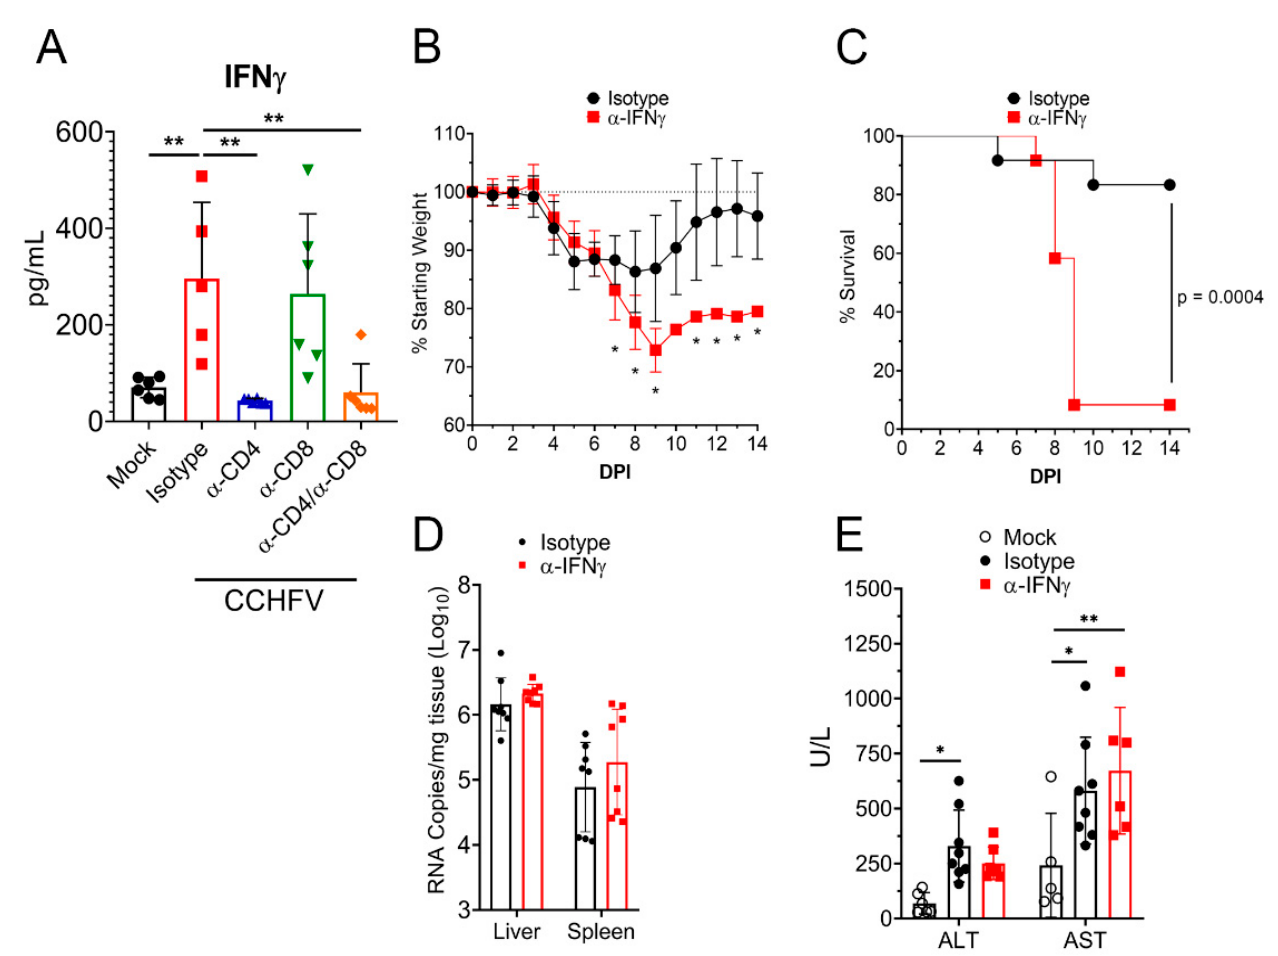
Figure 6. IFN γ is required for survival following CCHFV infection. ( A ) IFNAR − / − mice were infected with CCHFV or mock-infected. Mice were treated as indicated with isotype-control antibody, antibody to deplete CD4 or CD8 T-cells or both. On day 8 PI, plasma IFN γ levels in mice were measured by Bio-plex assay. Statistical comparison performed with a one-way ANOVA and Tukey’s multiple comparison test. ( B – D ) IFNAR − / − mice were infected with CCHFV and treated with isotype-control antibody or α -IFN γ antibody to neutralize IFN γ . Mice were weighed daily ( B ) and euthanized according to criteria outlined in methods ( C ). ( B ) N = 12 per group. Statistical comparison between isotype-control treated and α -IFN γ -treated mice performed with a two-way ANOVA with Sidak’s multiple comparison test. * p < 0.05. ( C ) N = 12 per group. Statistical test between survival curves performed using Log-rank test. ( D ) At day 8 PI, viral RNA loads in the liver or spleen were quantified by qRT-PCR. Statistical test comparing isotype-control treated and α -IFN γ -treated mice performed using two-way ANOVA with Sidak’s multiple comparison test. p > 0.05. ( E ) At day 8 PI, in mock-infected or CCHFV-infected mice treated with isotype control or IFN γ neutralizing antibody, blood levels of alanine aminotransferase (ALT) and aspartate aminotransferase (AST) were evaluated. Indicated statistical comparisons performed using an ordinary Two-way ANOVA with Tukey’s multiple comparison test. * p < 0.05, ** p < 0.01 .